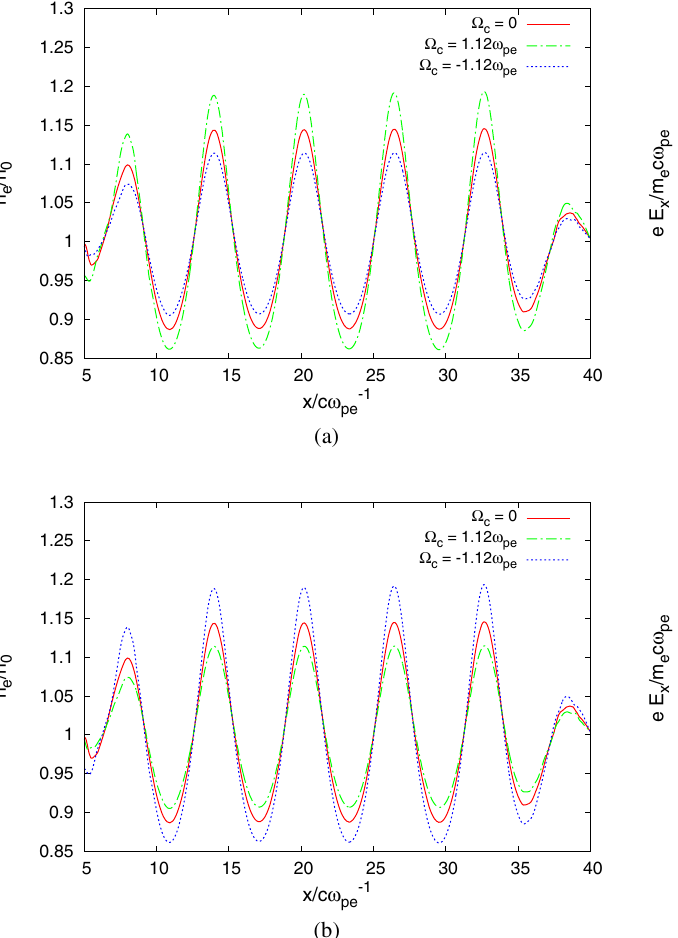
FIG. 2. Comparison of electron density fluctuations n e induced by propagation of (a) RCP and (b) LCP laser pulses in a nonmagnetized plasma Ω c ¼ 0 (solid red line), plasma with an external magnetic field in positive x direction Ω c ¼ 1 . 12 ω (green dash dot line) and negative x direction Ω c ¼ − 1 . 12 ω ≃ 40 after the start of simulation. (blue dot line) at t= ω − 1 pe